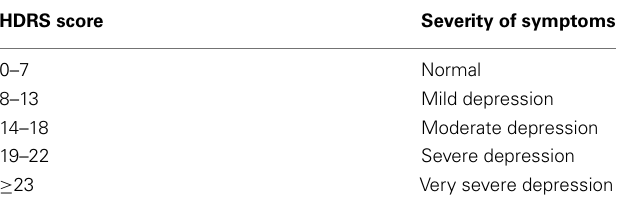
Table 3 | Interpretation of HDRS